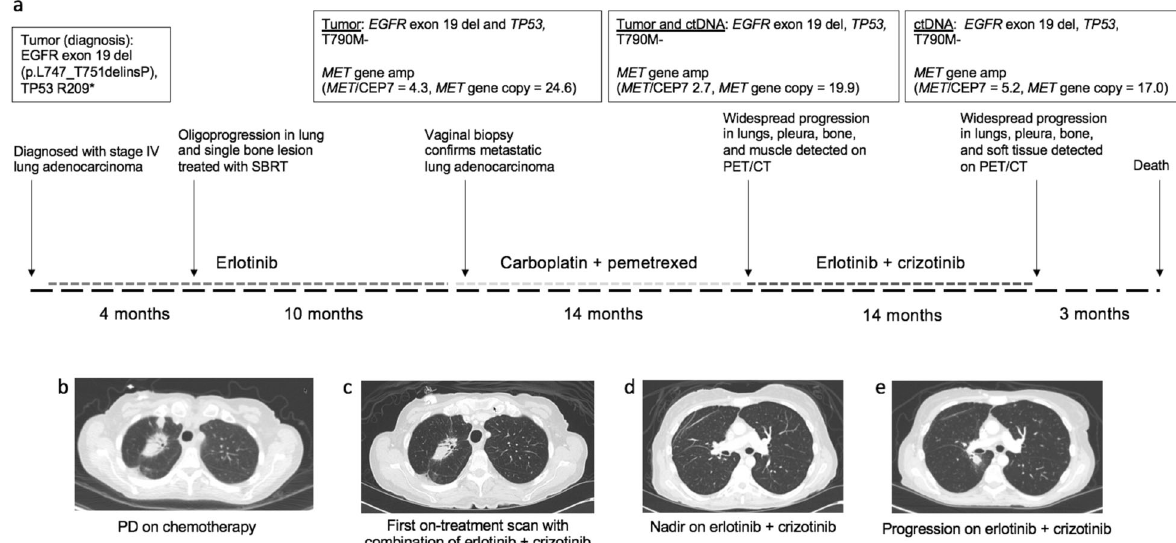
Fig. 1 Patient treatment history. a Timeline of the patient ’ s diagnosis and treatments, with molecular testing results shown in boxes. b CT scan demonstrates post chemotherapy (pre-erlotinib/crizotinib) with lung nodules. c The fi rst on-treatment CT chest scan during erlotinib and crizotinib treatment demonstrate reduction or disappearance of lung nodules. d A CT chest of this patient at the radiographic nadir while on erlotinib and crizotinib with complete resolution of lung nodules. e A CT chest of this patient at the time of progression on erlotinib and crizotinib with new perihilar lung